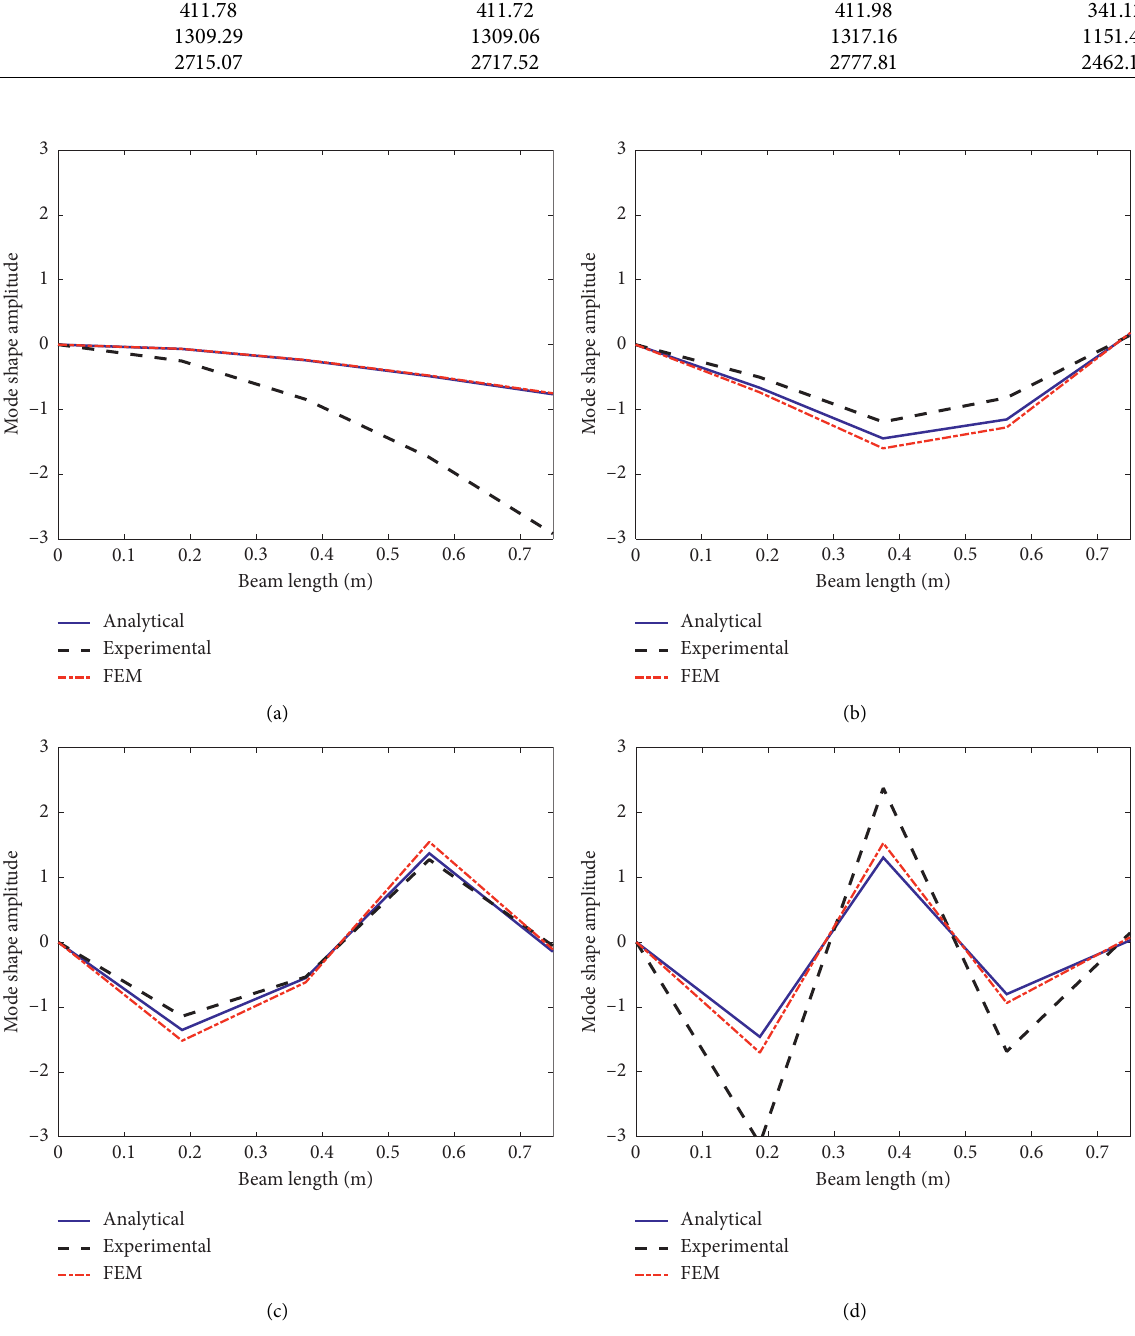
Figure 5: The first four mode shapes of the beam in the analytical, numerical (4 elements), and experimental methods. (a) Mode no. 1. (b) Mode no. 2. (c) Mode no. 3. (d) Mode no.